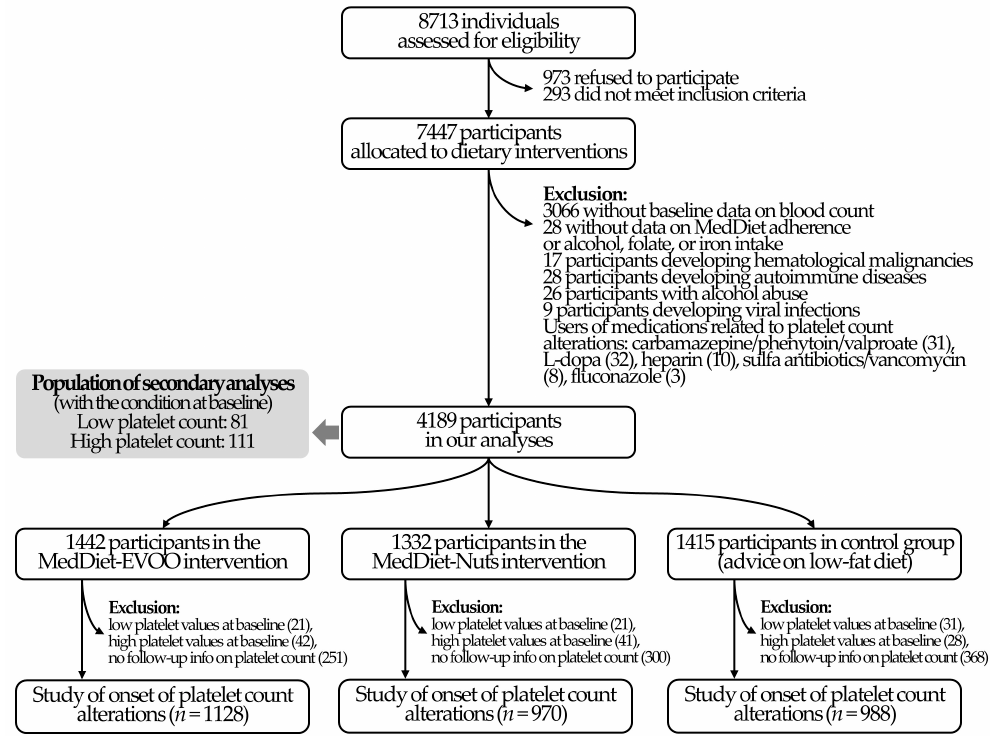
Figure 1. Study flowchart. MedDiet: Mediterranean diet; MedDiet-EVOO: MedDiet enriched with extra-virgin olive oil; MedDiet-Nuts: MedDiet enriched with mixed nuts.